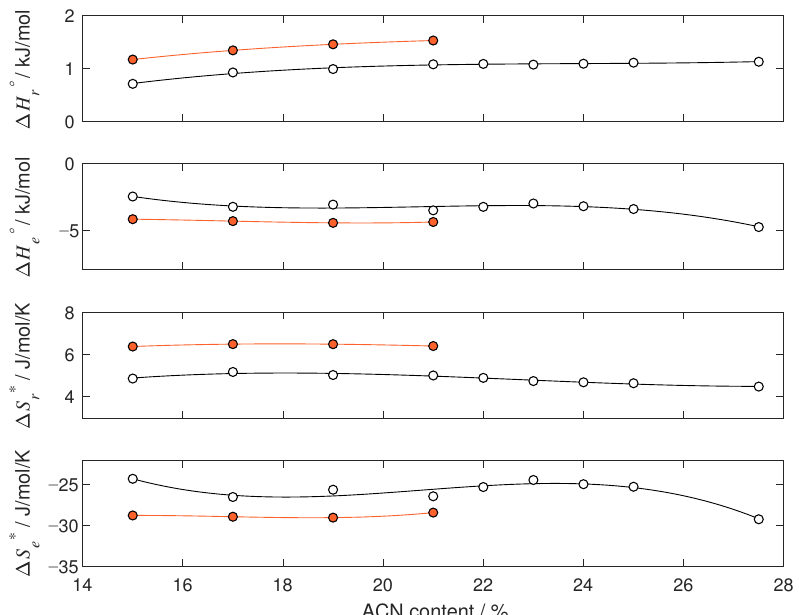
Figure 4. Comparison of thermodynamic parameters for the preparative and the analytical column as function of the mobile phase composition. Filled symbols—preparative column (for values see Table 2), open symbols—analytical column (data from [15]). Lines—interpolation by third-order polynomials. The coefficients are tabulated in the Supplementary Information.